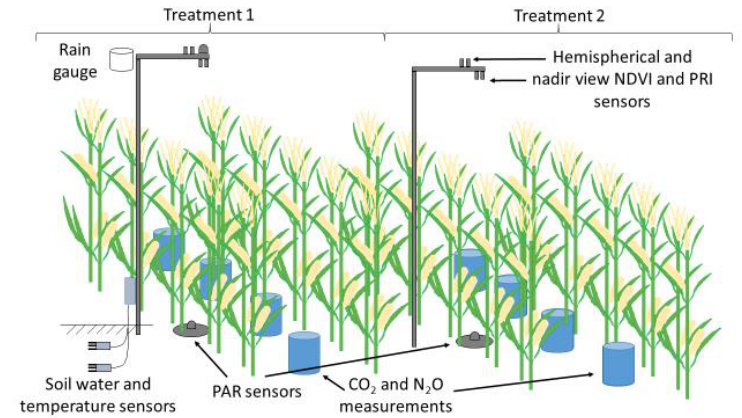
Figure 1. Schematics of the experimental setup.